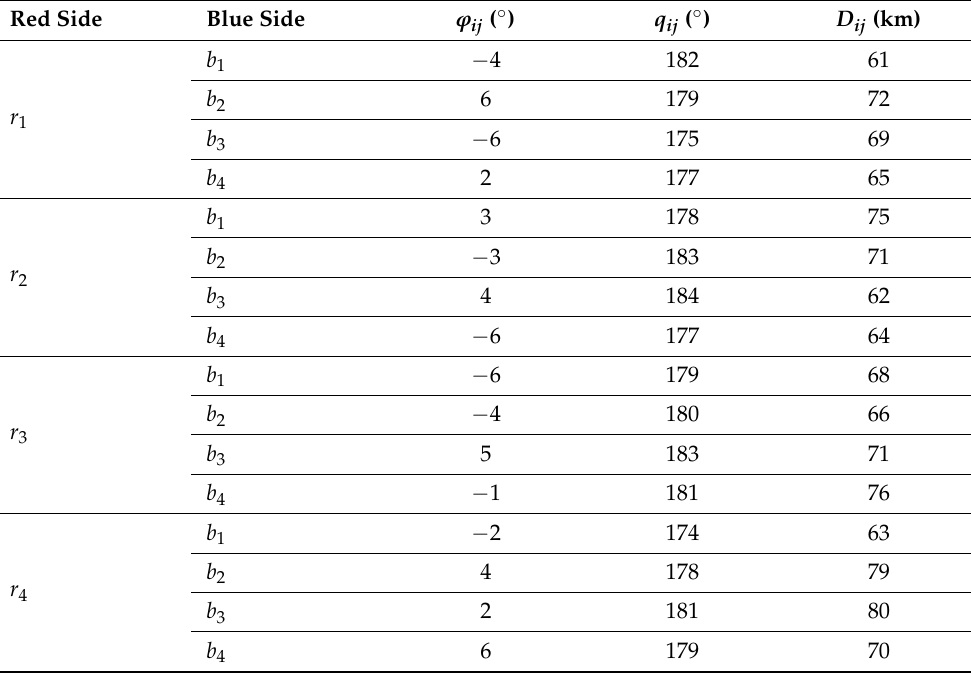
Table 2. Situation information of the blue side relative to the red